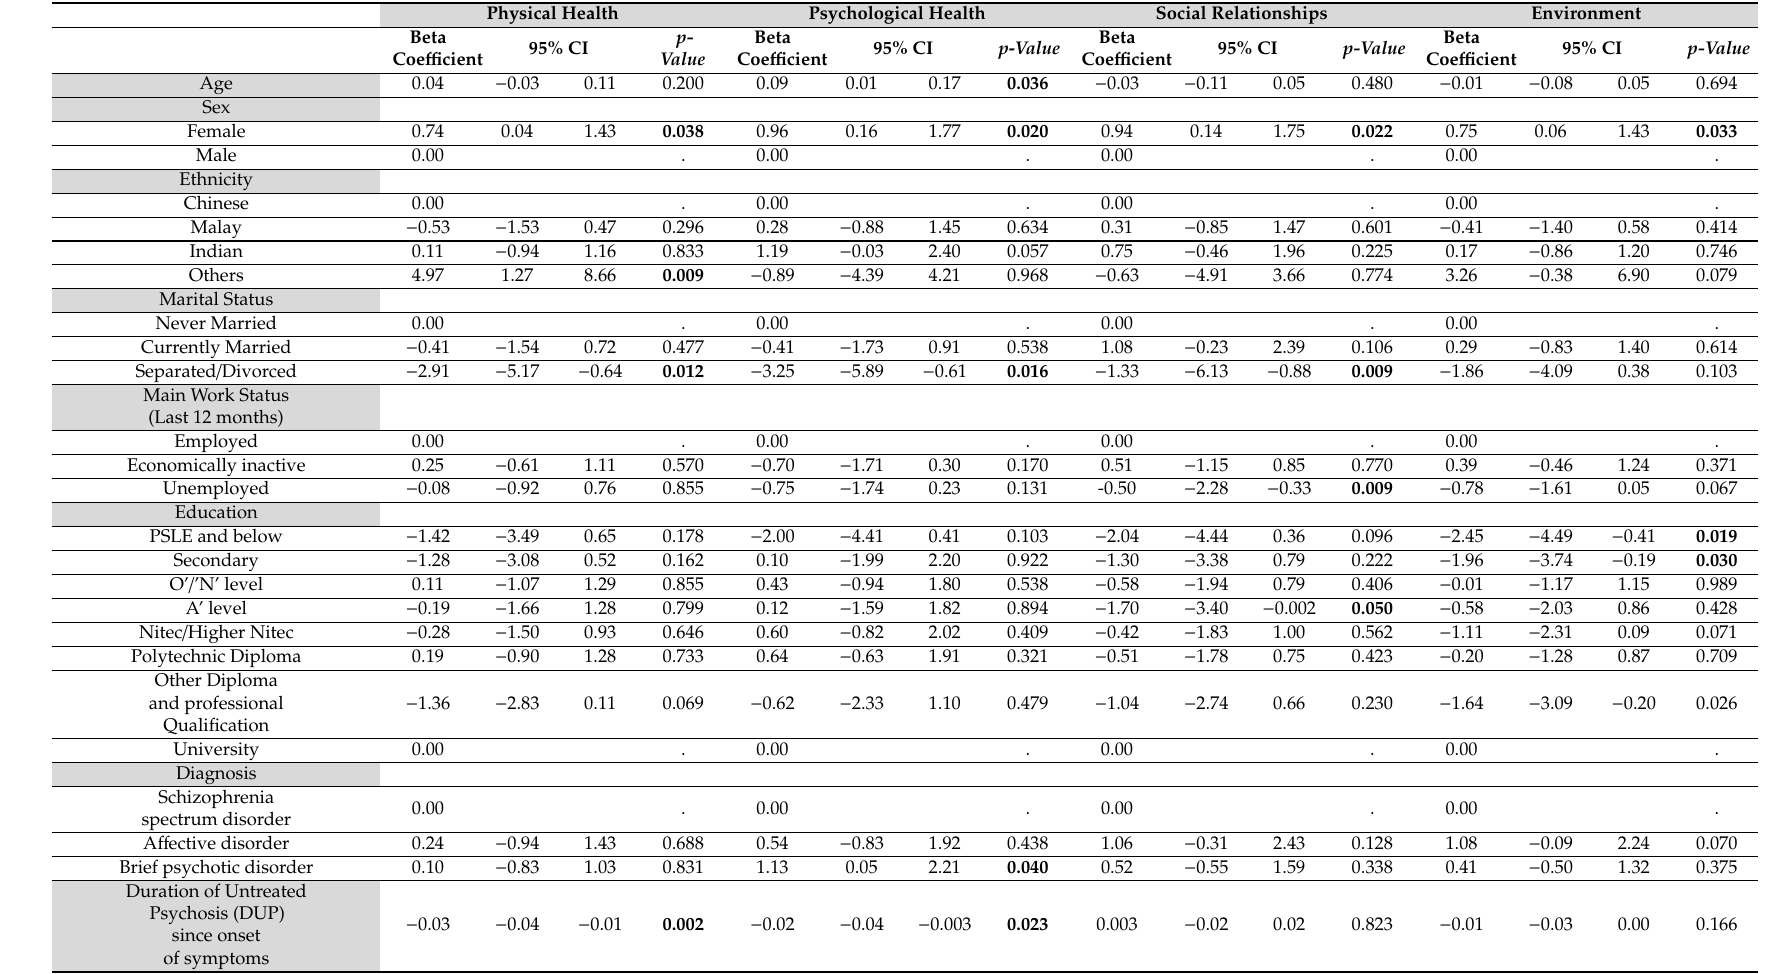
Table 2. Sociodemographic and clinical correlates of WHOQOL-BREF at